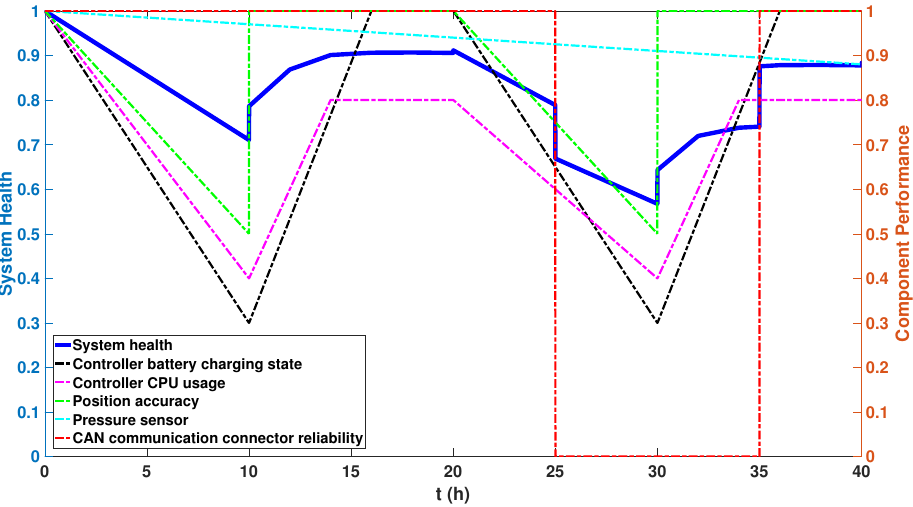
Figure 7. The simulation results of scenario case